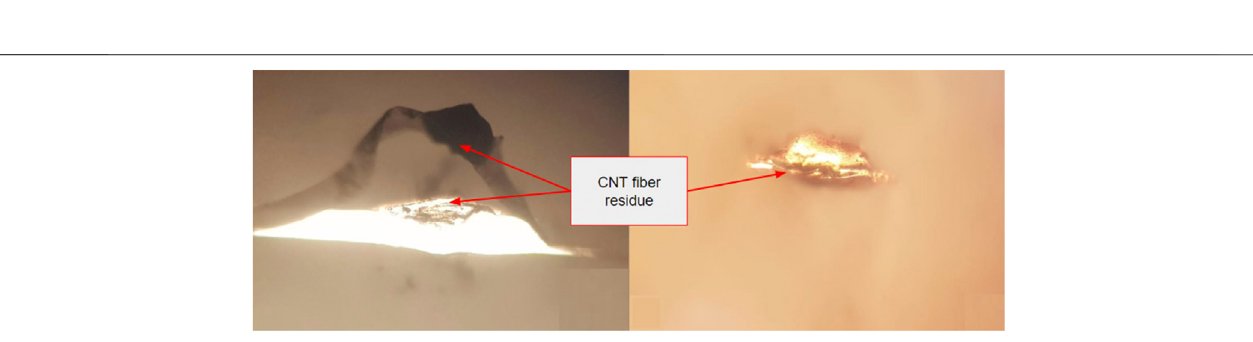
FIGURE8| Fouraxisgraphdepictingthemeasuredvoltage,temperatureandforcewithrespecttotimeforthepenetrationtestofapureCNTEDLCandCNT/PANI sample.